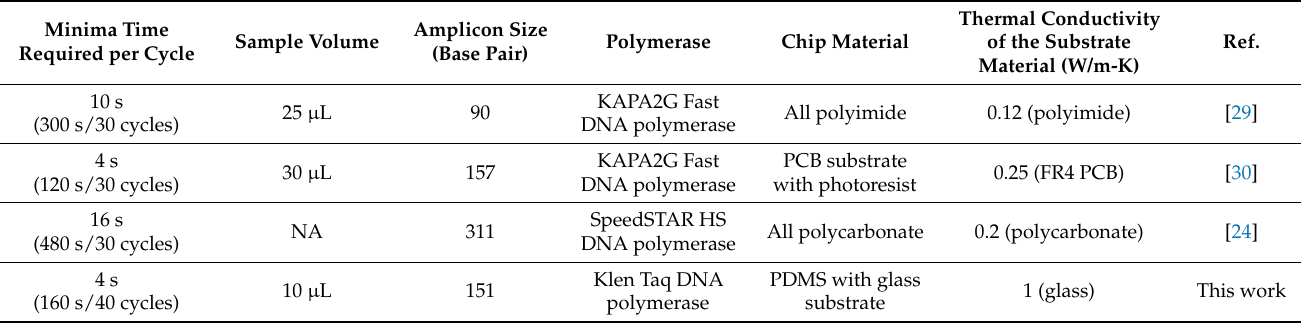
Table 1. Comparison of the experimental result to similar studies performing ultrafast PCR using continuous-flow-based microfluidic